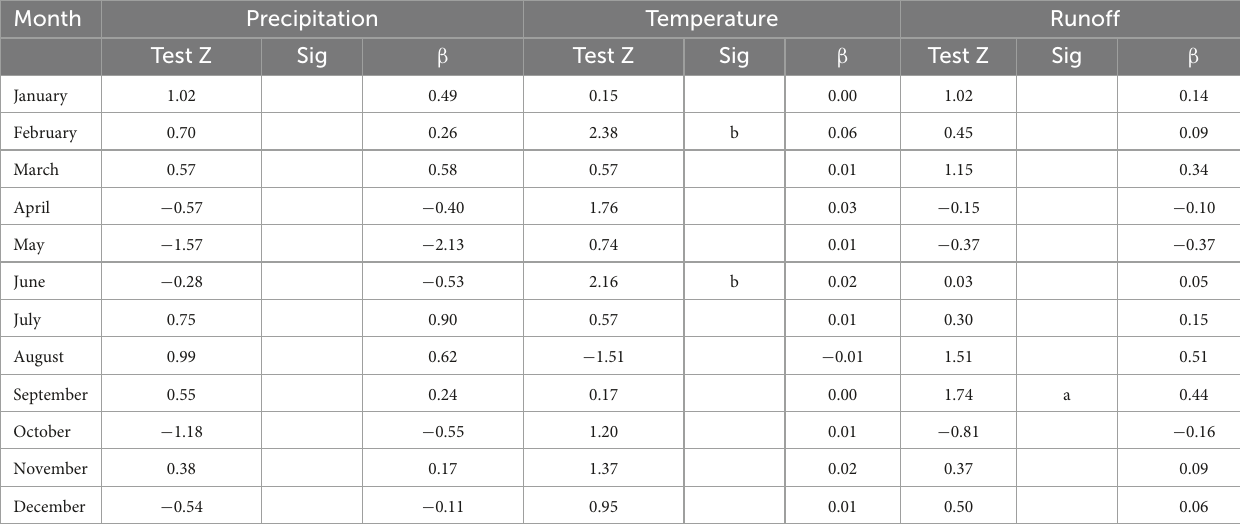
TABLE 3 Mann-Kendall (M-K) test results of hydrometeorological elements.